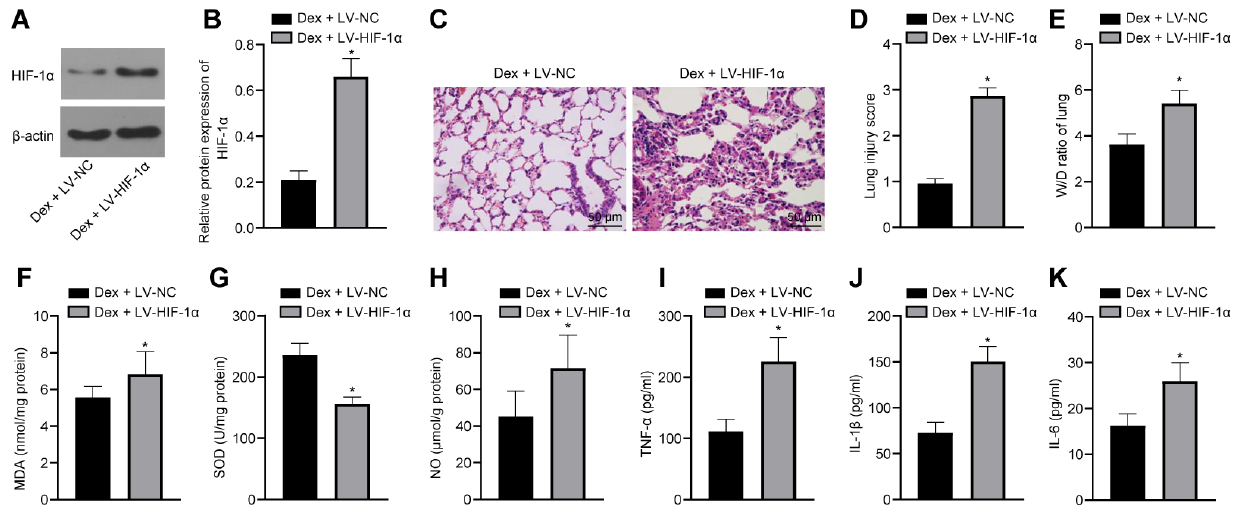
Fig. 6 - Dexmedetomidine (Dex) attenuates diabetic myocardial ischemia/reperfusion-induced acute lung injury by limiting hypoxia-inducible factor-1α (HIF-1α). A-B) HIF-1α expression (A) and grey value (B) in lung tissues from each group after being treated by Dex + lentiviral vector (LV)- HIF-1α for four weeks detected by western blot analysis. C-E) Representative hematoxylin and eosin staining images (×200) (C), pathological score (D), and the wet/dry weight (W/D) ratio in lung tissues from each group after being treated with Dex + LV-HIF-1α for four weeks. F-H) Levels of oxidative stress indicators including malondialdehyde (MDA) (F), superoxide dismutase (SOD) (G), and nitric oxide (NO) (H) in lung tissues from each group after being treated with Dex + LV-HIF-1α for four weeks. I-K) Tumor necrosis factor-α (TNF-α) (I), interleukin (IL)-1β (J), and IL-6 (K) in lung tissues from each group after being treated with Dex + LV-HIF-1α for four weeks (n=6). The t-test was employed to verify statistical significance. *P<0.05, compared with the Dex + LV-negative control (NC) group. DIR=diabetic + ischemia/reperfusion; DS=diabetic sham; NIR=non-diabetic + ischemia/reperfusion; NS=non-diabetic sham.